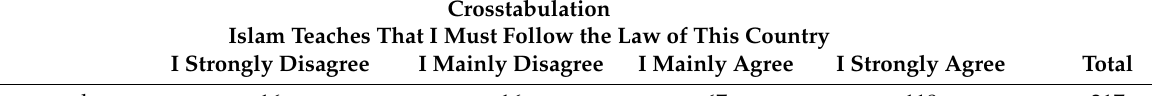
Table 1. Male and female responses to “Islam teaches that I must follow the law of this country”. Crosstabulation